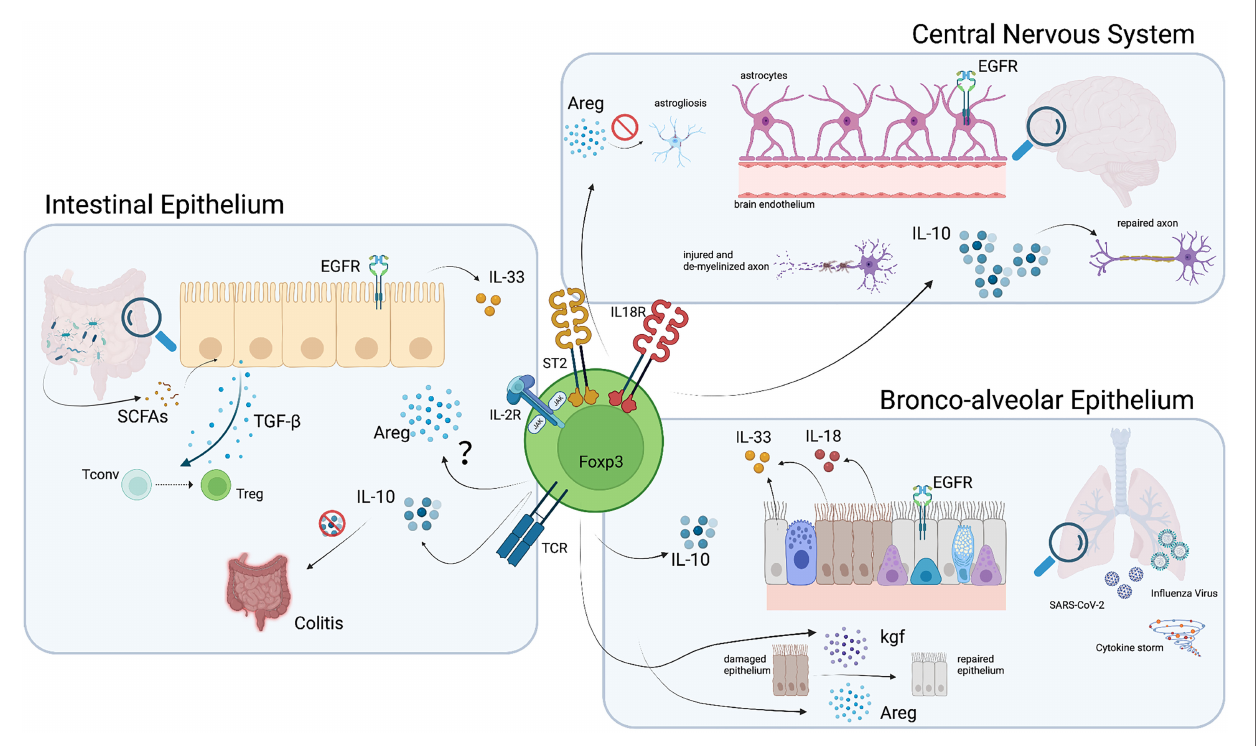
FIGURE 3 | Pathways and molecules involved in Treg function in non-lymphoid organs. Tregs which home to the brain, lung and intestine acquire phenotypic characteristics that potentiate their function in these organs. Among these, the production of Areg and anti-in fl ammatory cytokines such as IL-10 and TGF- b , mediate Treg protective and reparative action. Illustration created with